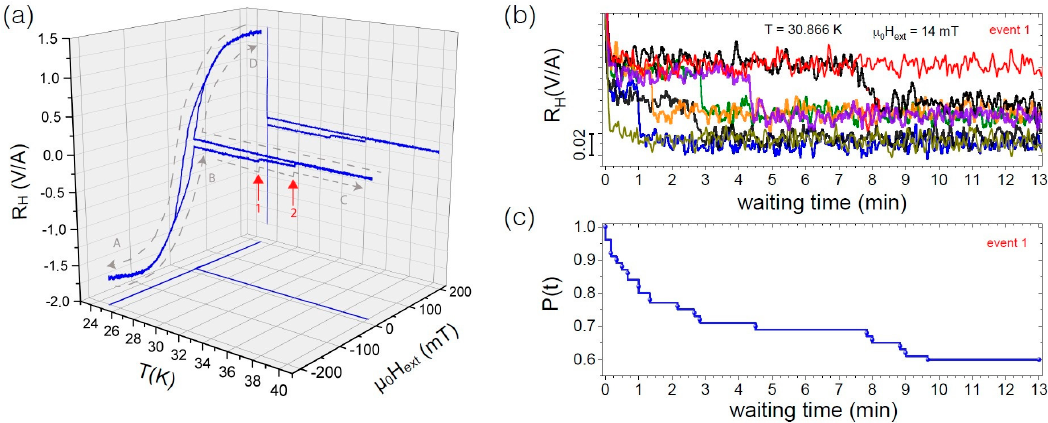
Figure 3. ( a ) Temperature and magnetic field protocol for thermal activation of a single switching event within the nano-cubes’ hysteresis loop taken at θ = 0 ◦ . A: Saturation at negative fields at T = 25K. B: Preparation of the state at µ 0 H ext = 14mT. C: Two major thermally activated switching events are observed (red arrows) while warming up to T = 40K in a fixed field of 14mT. D: Cool-down